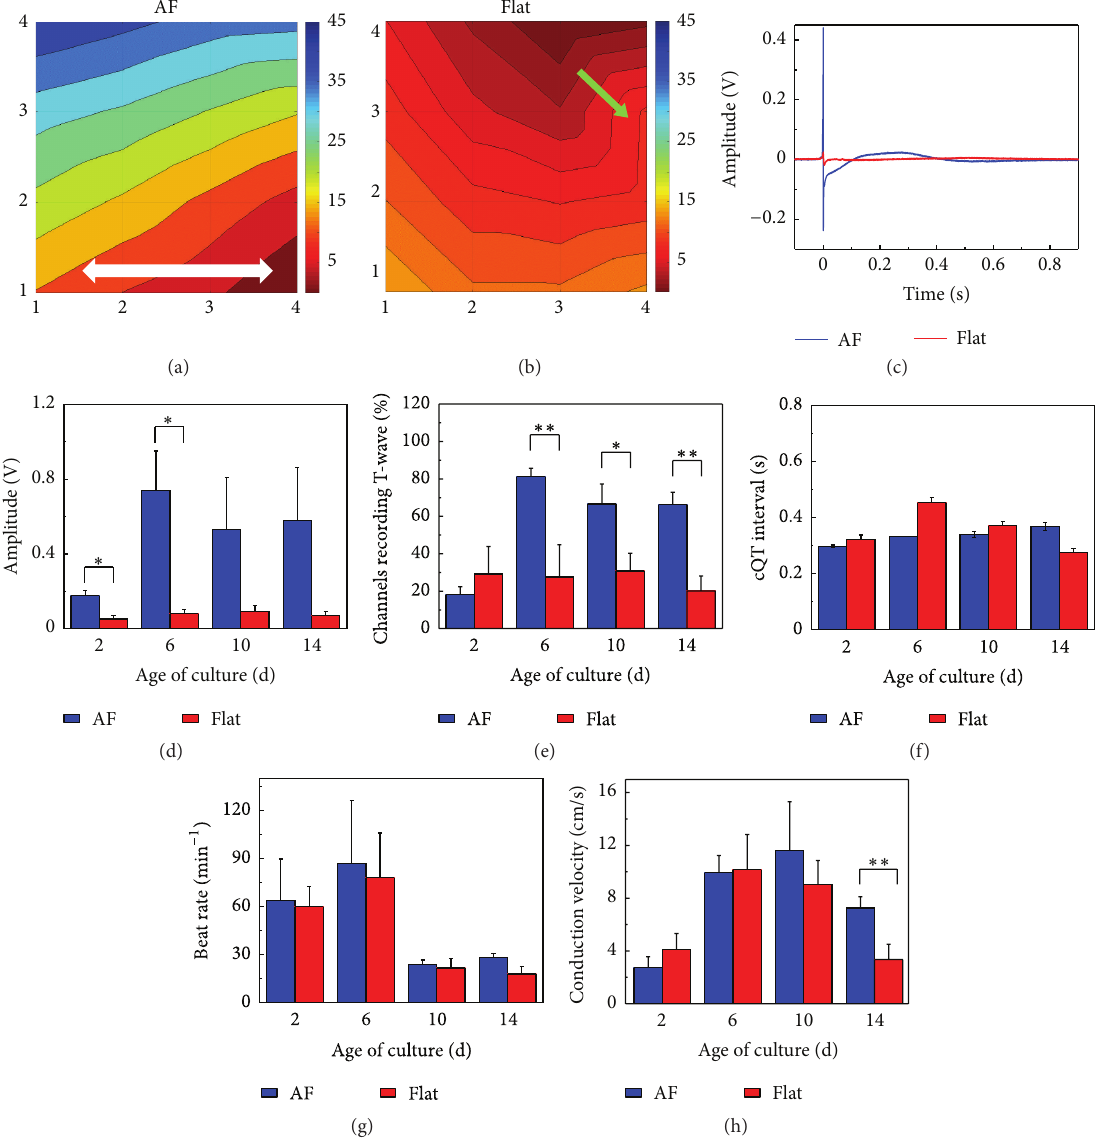
Figure 5: Electrical characterization of IMR hiPS-cardiomyocytes (CMs). (a-b) Activation maps showing the propagation of contraction on day 6. The white arrow marks the fiber orientation and the green arrow marks the delay area. (c) Field potentials (FPs) of CMs cultured on the two types of substrates at day 6. (d) Amplitude of FP at different culture times (means ± s.e., 𝑛 = 3 , ∗ 𝑃 < 0.05 ). (e) The ratio of the channels recording the T-wave (means ± s.e., 𝑛 = 3 , ∗ 𝑃 < 0.05 , ∗∗ 𝑃 < 0.01 ). (f) cQT intervals recorded from CMs at different culture times (means ± s.e., 𝑛 = 3 ). (g) CM beating rate at different culture times (means ± s.e., 𝑛 = 3 ). (h) Conduction velocity of spontaneous contraction propagation at different culture times (means ± s.e., 𝑛 = 3 , ∗∗ 𝑃 < 0.01 ).